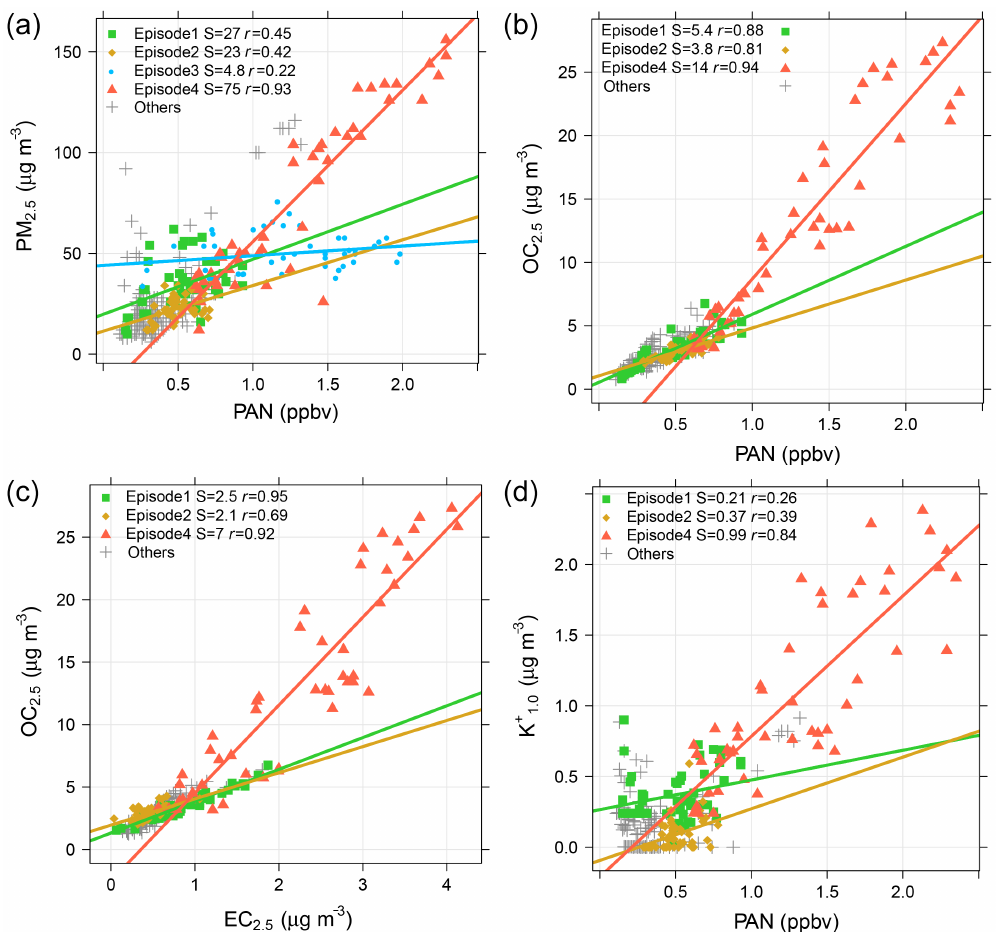
Figure 6. Correlations among PAN, the K + ion of PM 1 . 0 , and carbonaceous components of PM 2 . 5 for four episodes: (a) PAN and PM 2 . 5 mass, (b) PAN and PM 2 . 5 OC, (c) PM 2 . 5 EC and OC, and (d) PAN and PM 1 . 0 K + . The lines represent the linear regression for each